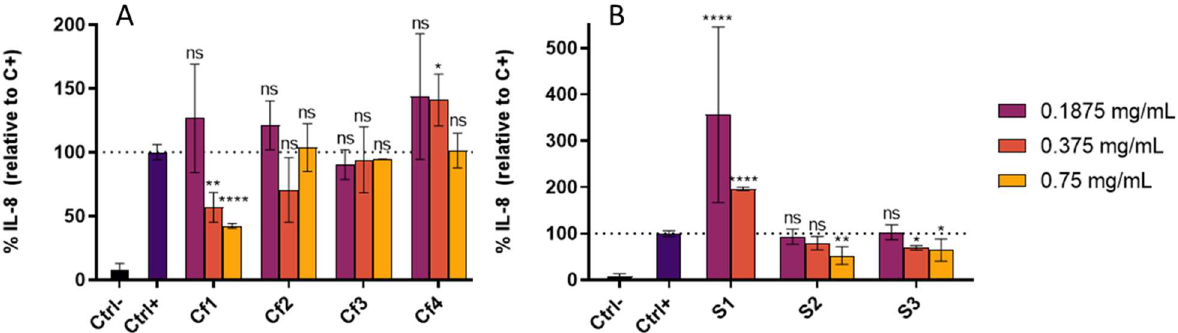
Figure 2. IL-8 secreted by HaCaT cells treated for 24 h with different extracts concentrations and 15 µg/mL LPS. ( A ) Codfish residues extracts; ( B ) Sardine residues extracts. Ctrl-—cells incubated with only culture media; Ctrl+—Cells incubated with culture media + inflammation inductor (LPS); Cf1, Cf2, Cf3, Cf4—cells incubated with the different extracts from codfish frames + inflammation inductor (LPS); S1, S2, S3—cells incubated with the different extracts from sardine wastes + inflammation inductor (LPS). The results are expressed as mean IL-8 percentage relative to the positive control ± SD. The symbol * indicates significance relative to the positive control (* p -value ≤ 0.05, ** p -value ≤ 0.01, **** p -value ≤ 0.0001); ns—not significant.